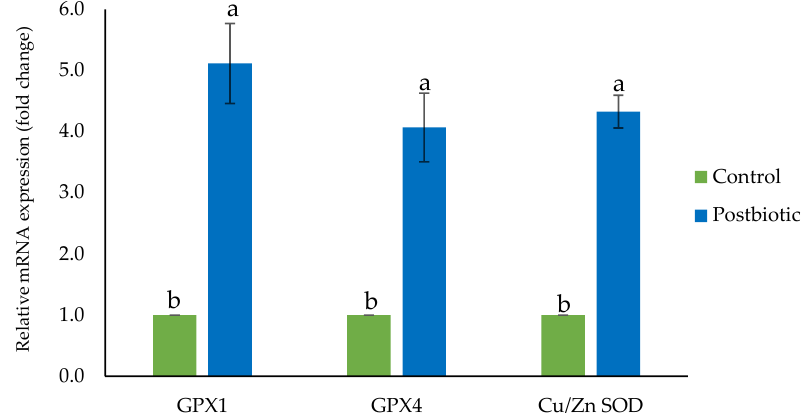
Figure 2. Gene expression of hepatic antioxidant enzymes of post-weaning lambs supplemented with and without postbiotic L. plantarum RG14. GPX1 : Glutathione peroxidase 1, GPX4 : Glutathione peroxidase 4, Cu / Zn SOD : Cu, Zn Superoxide dismutase. a,b Bars with di ff erent letters between treatment groups are significantly di ff erent ( p <